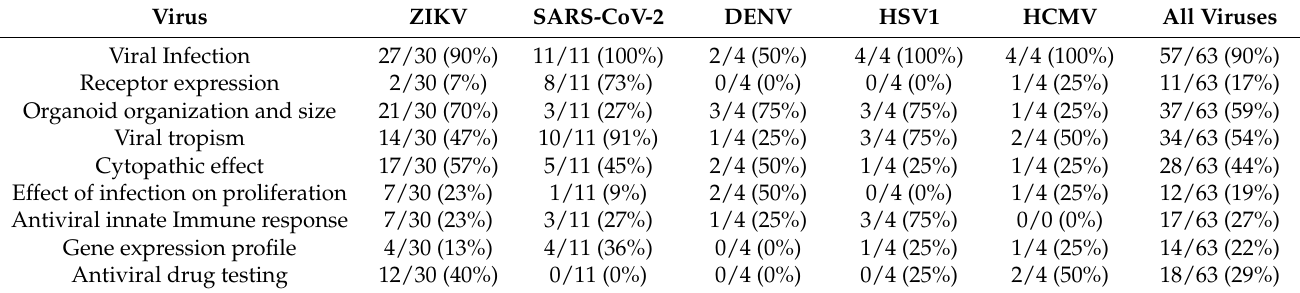
Table 1. Research topics on brain organoid viral infection, depicted as percentage of studies that have reported on these different research subjects.